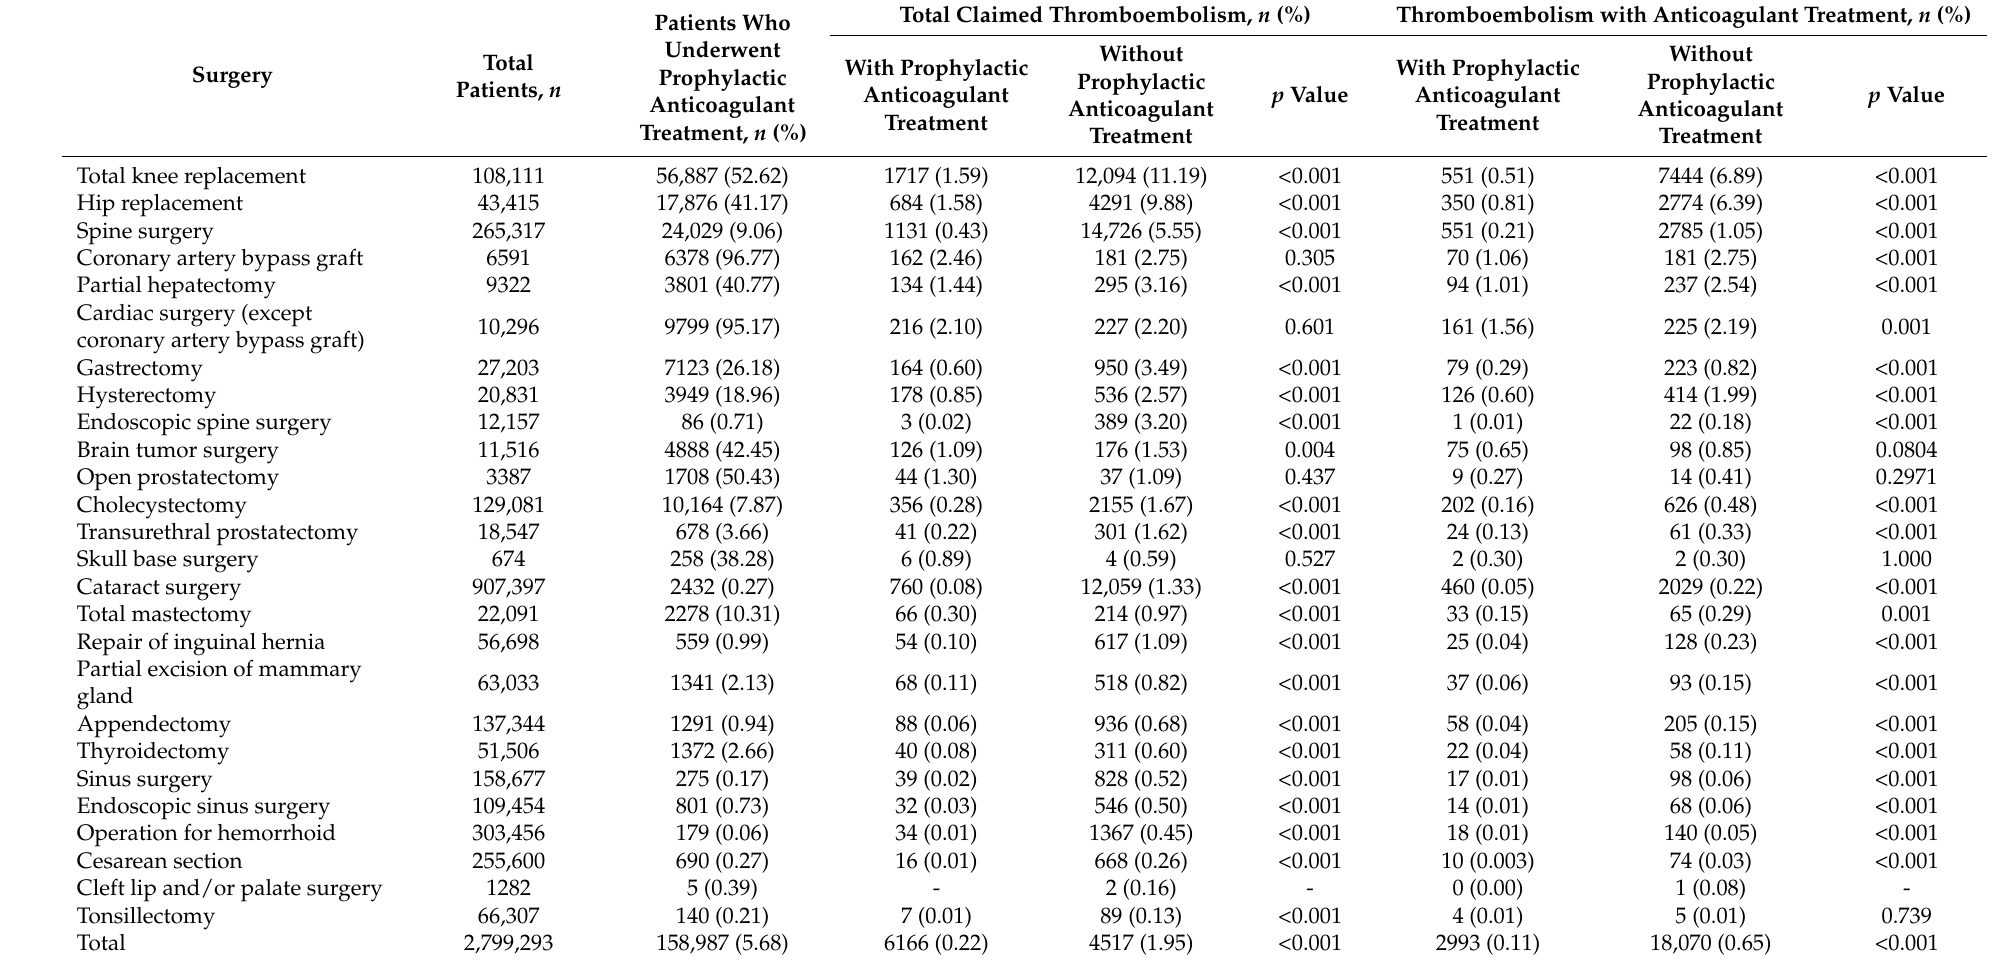
Table 2. Proportion of patients who underwent prophylactic anticoagulant treatment and its effect on the incidence of TE